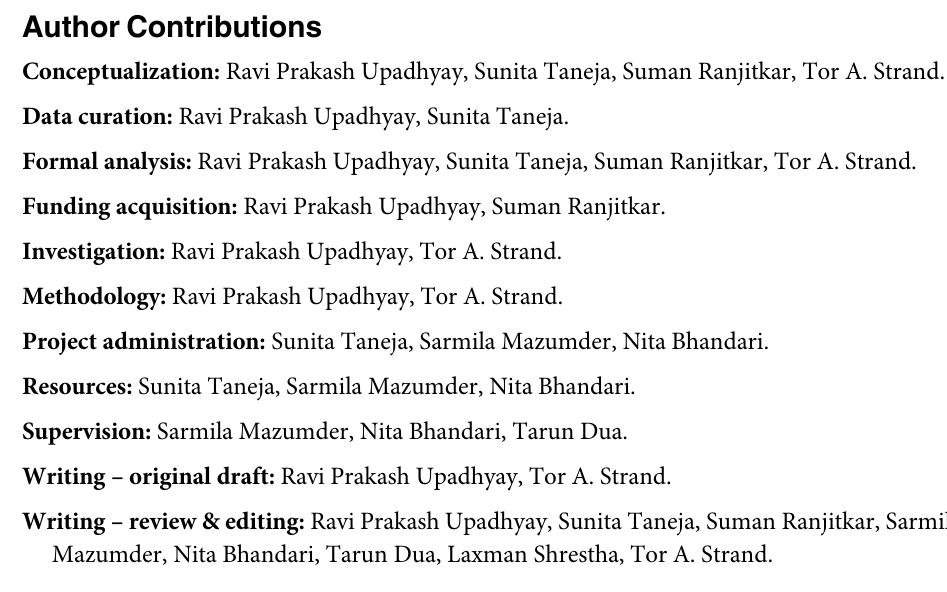
S1 Table. Findings on univariable linear regression for cognitive, language and motor scores at 12 months of infant age in low birth weight infants from rural